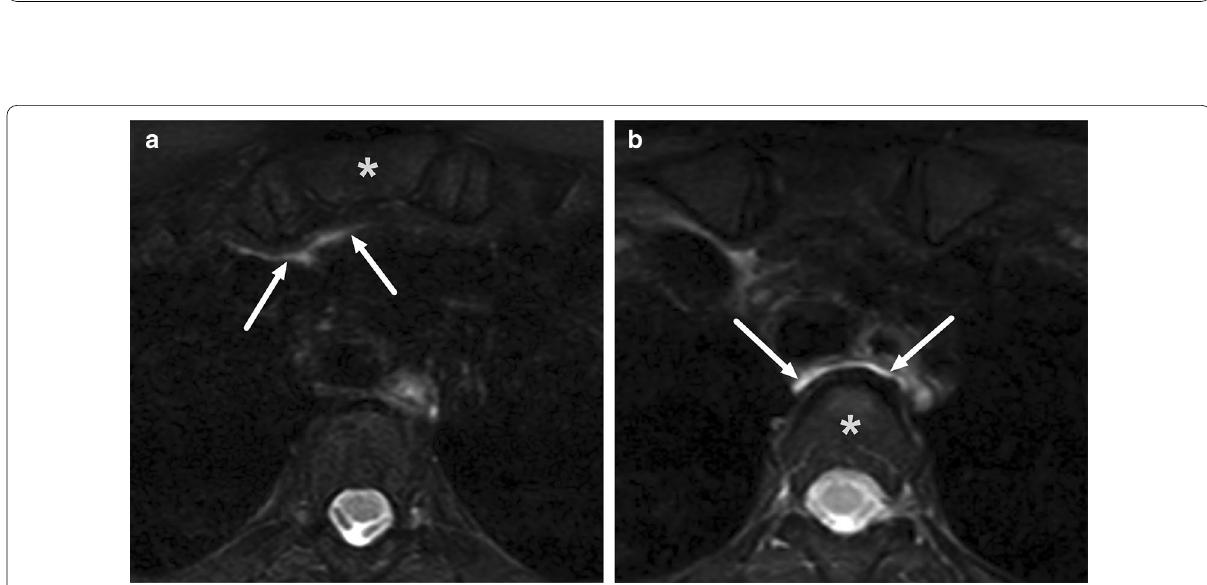
Fig. 9 Examples of RPE (arrows) on axial fat-suppressed T2-weighted images in different patients ( a – f ) with infections of various origins. Image modified from ref. [12]